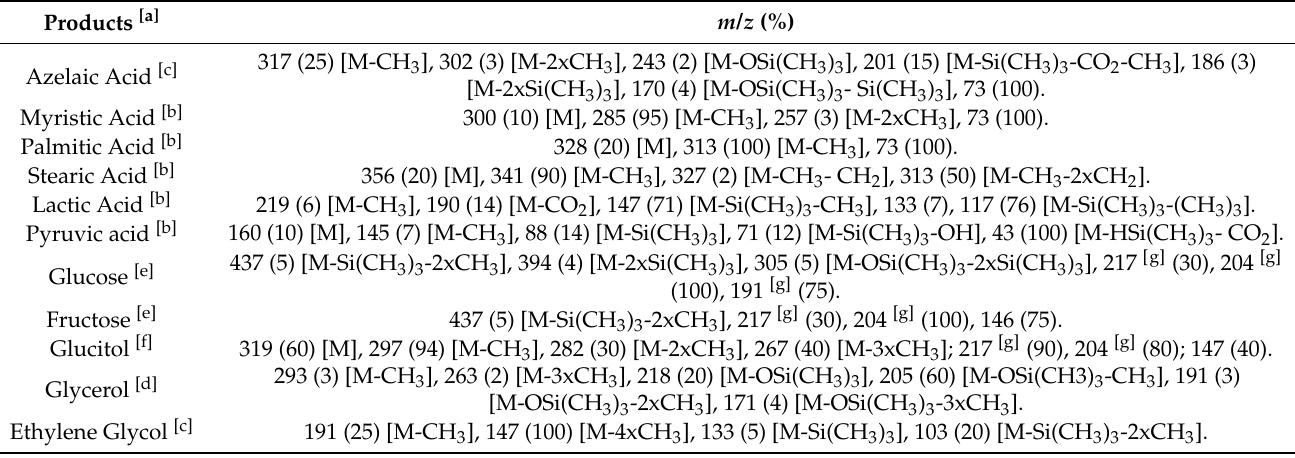
Table 3. Mass-to-charge ratio ( m/z ) value and the abundance of peaks of identified